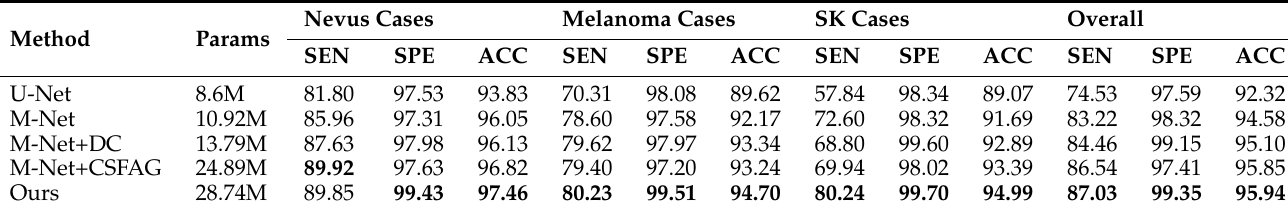
Table 3. ISIC-2017 data set, performance comparison of U-Net, M-Net, M-Net+DC (Dense Convolutions), M-Net+CSFAG and CSAG and DCCNet (ours) in sensitivity, specificity and accuracy. Bold data indicates that the value is the maximum value in this indicator.